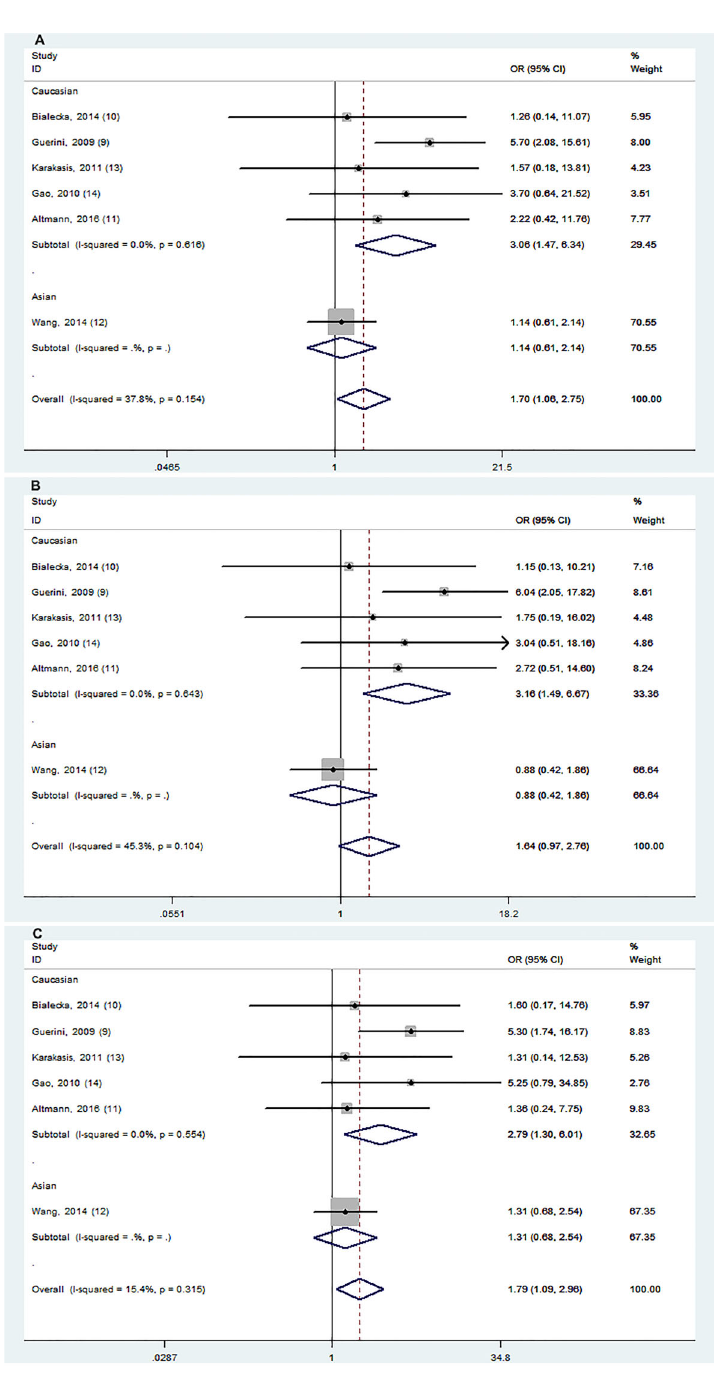
Figure 3 . Strati fi cation analyses of ethnicity between rs6265 and cognitive impairment in PD ( A : AA vs GA + GG; B : AA vs GG; C : AA vs